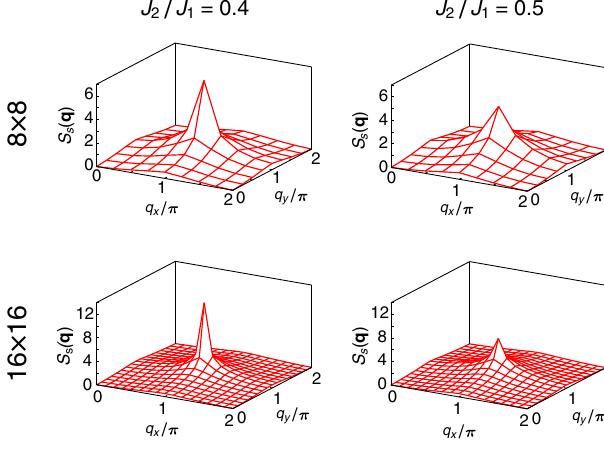
FIG. 14. Structure factor for spin-spin correlation S s ð q Þ